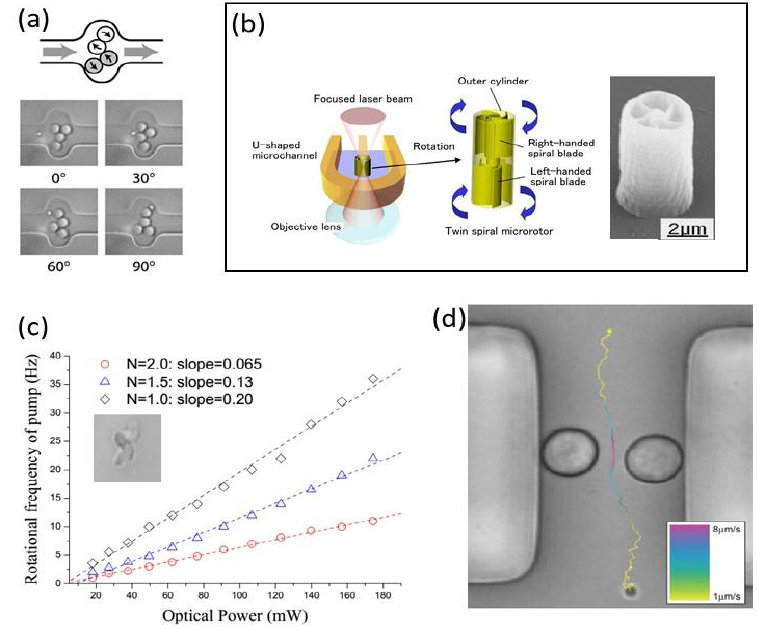
Figure 2. ( a ) Design of the gear microfluidic pump showing bead movement together with the screen shoots of 3µm silica beads 2 Hz rotation in a 6µm channel (From [59]. Reprinted with